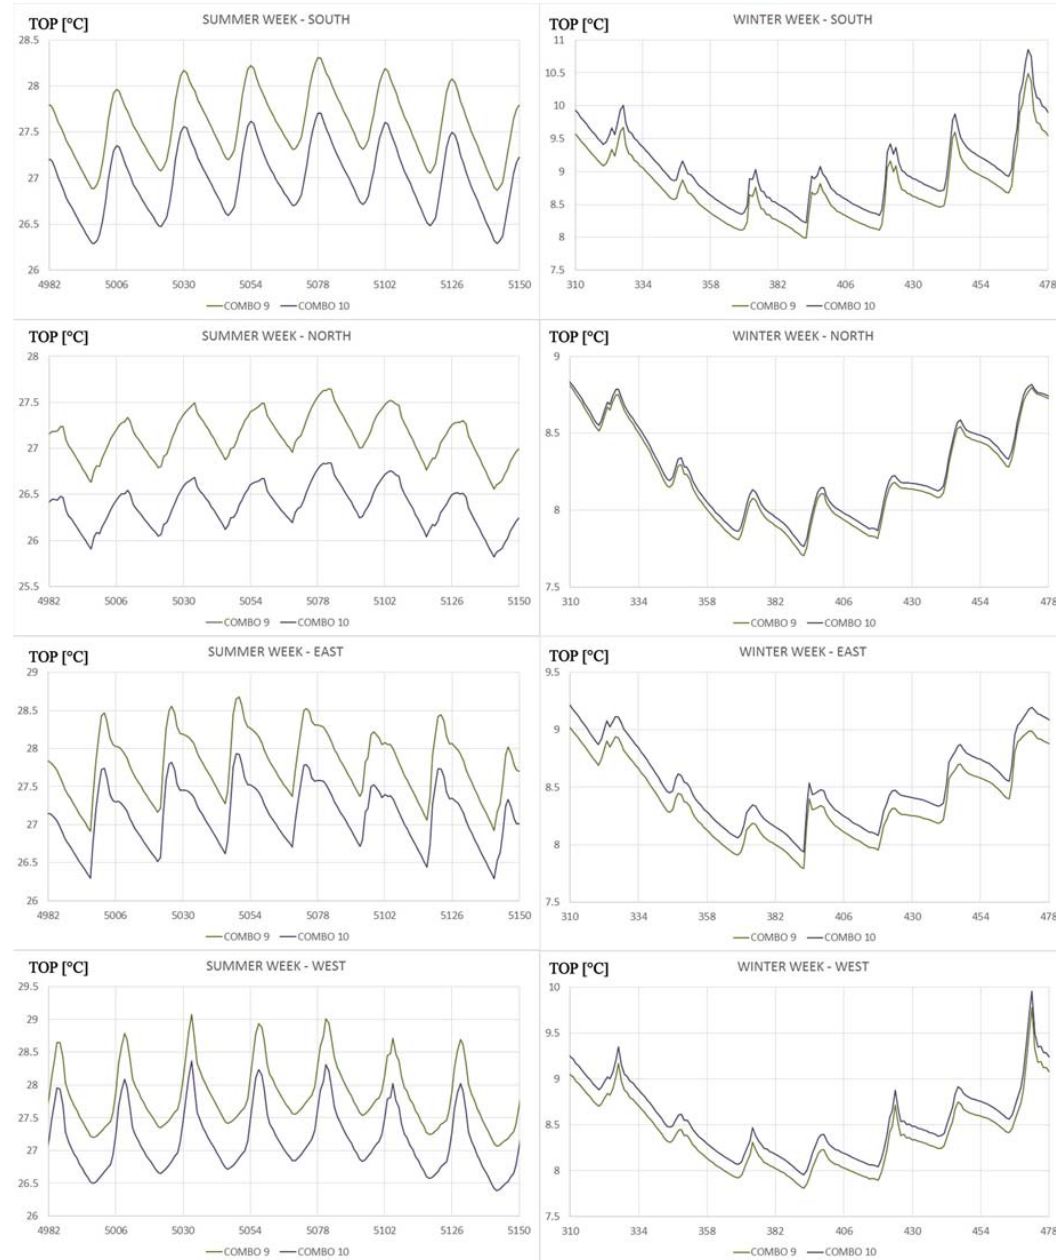
Figure 7. TOP graphical trend for the STEP 4 (27 July–2 August; 12 January–18 January).